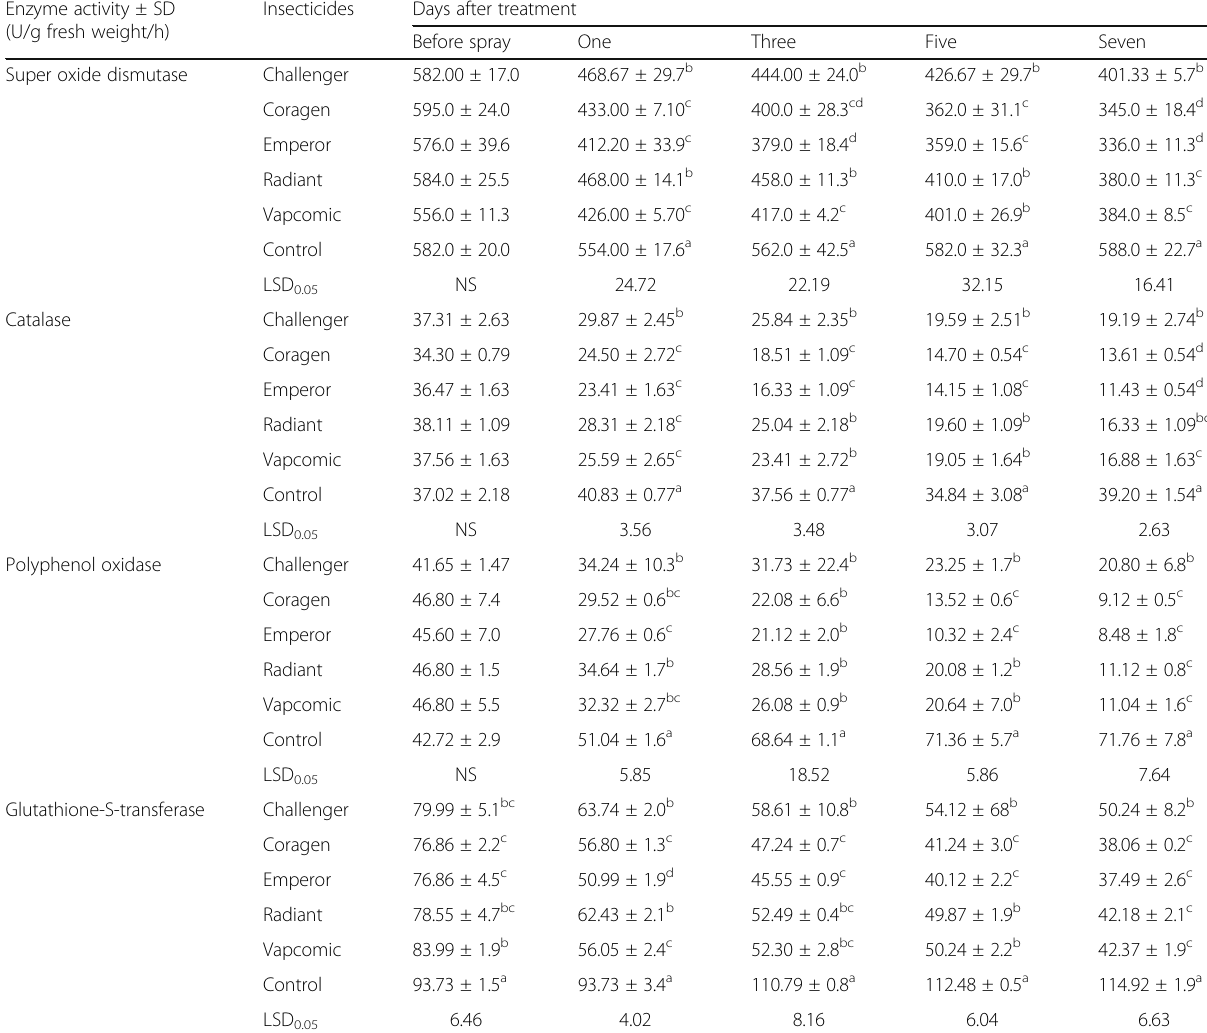
Table 6 Effect of the tested insecticides on certain antioxidant enzymes of tomato plants Enzyme activity ± SD (U/g fresh weight/h)